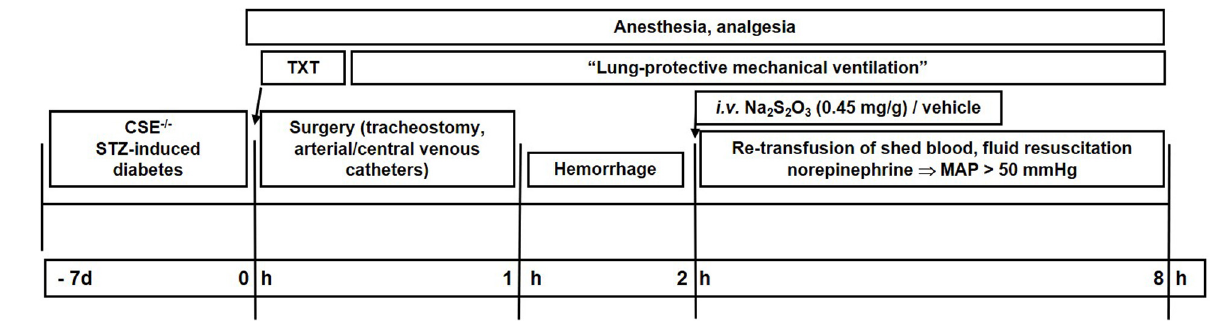
FIGURE 1 | Flow chart of the experimental procedure. Txt, thoraxtrauma; MAP, mean arterial pressure; HR, heart rate, STZ,